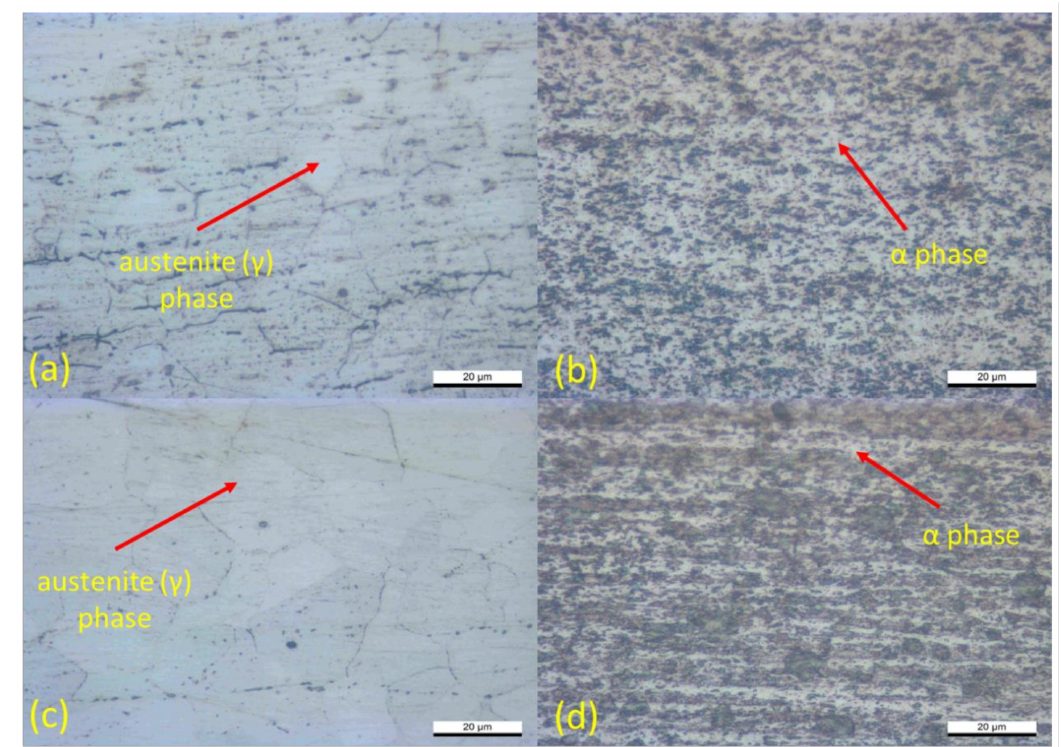
Figure 7. Microstructure of the base metal: ( a ) SS316L-sample 1; ( b ) Ti 6 Al 4 V -sample 1; ( c ) SS316L-sample 3; ( d ) Ti 6 Al 4 V -sample 3.